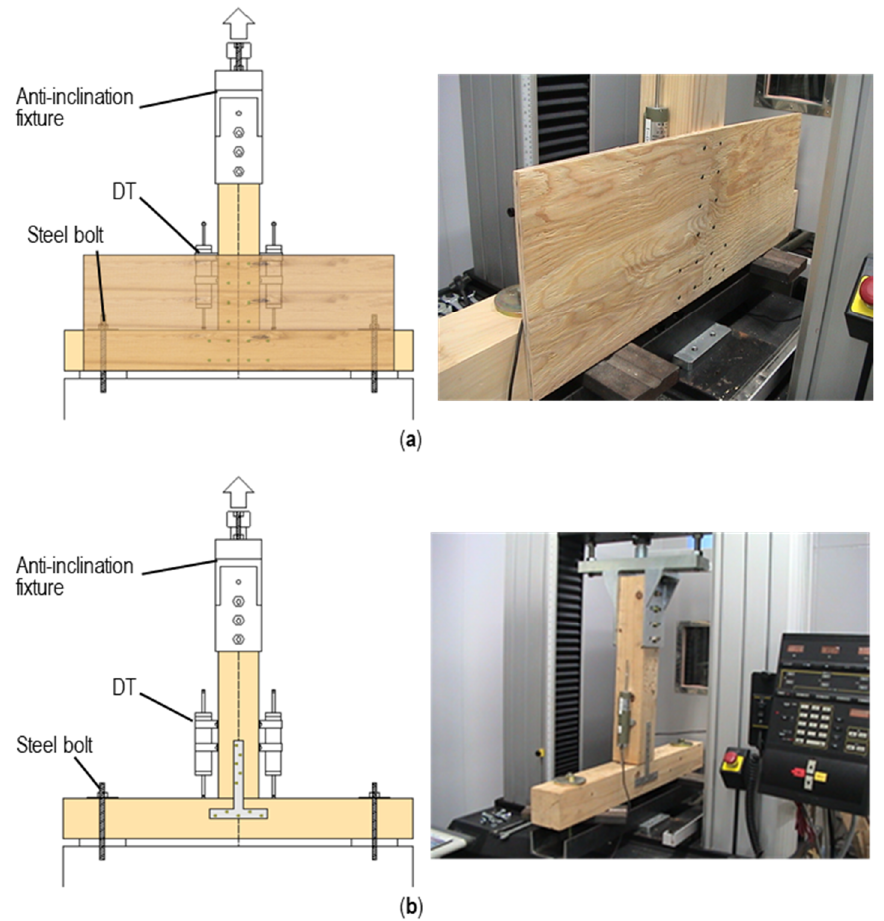
Figure 6. Test setup and instrumentation of pullout test specimen: ( a ) P and N specimen; ( b ) CP-T- type specimen. type